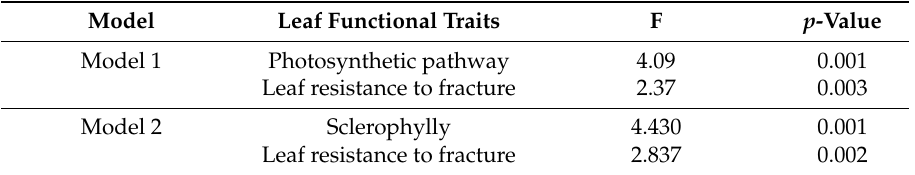
Figure 4. Distance-based redundancy analysis (dbRDA) ordination of leaf traits associated with endophyte communities of CAM and C 3 bromeliad species. Arrows represent significant positive associations between host functional traits and endophyte communities, and the length signifies the magnitude of the association ( n = 47). Table 3. PERMANOVA marginal test. Type III ANOVA-like permutational test. Associations between bromeliad functional traits and endophyte community composition (Bray–Curtis) constrained in a dbRDA model.